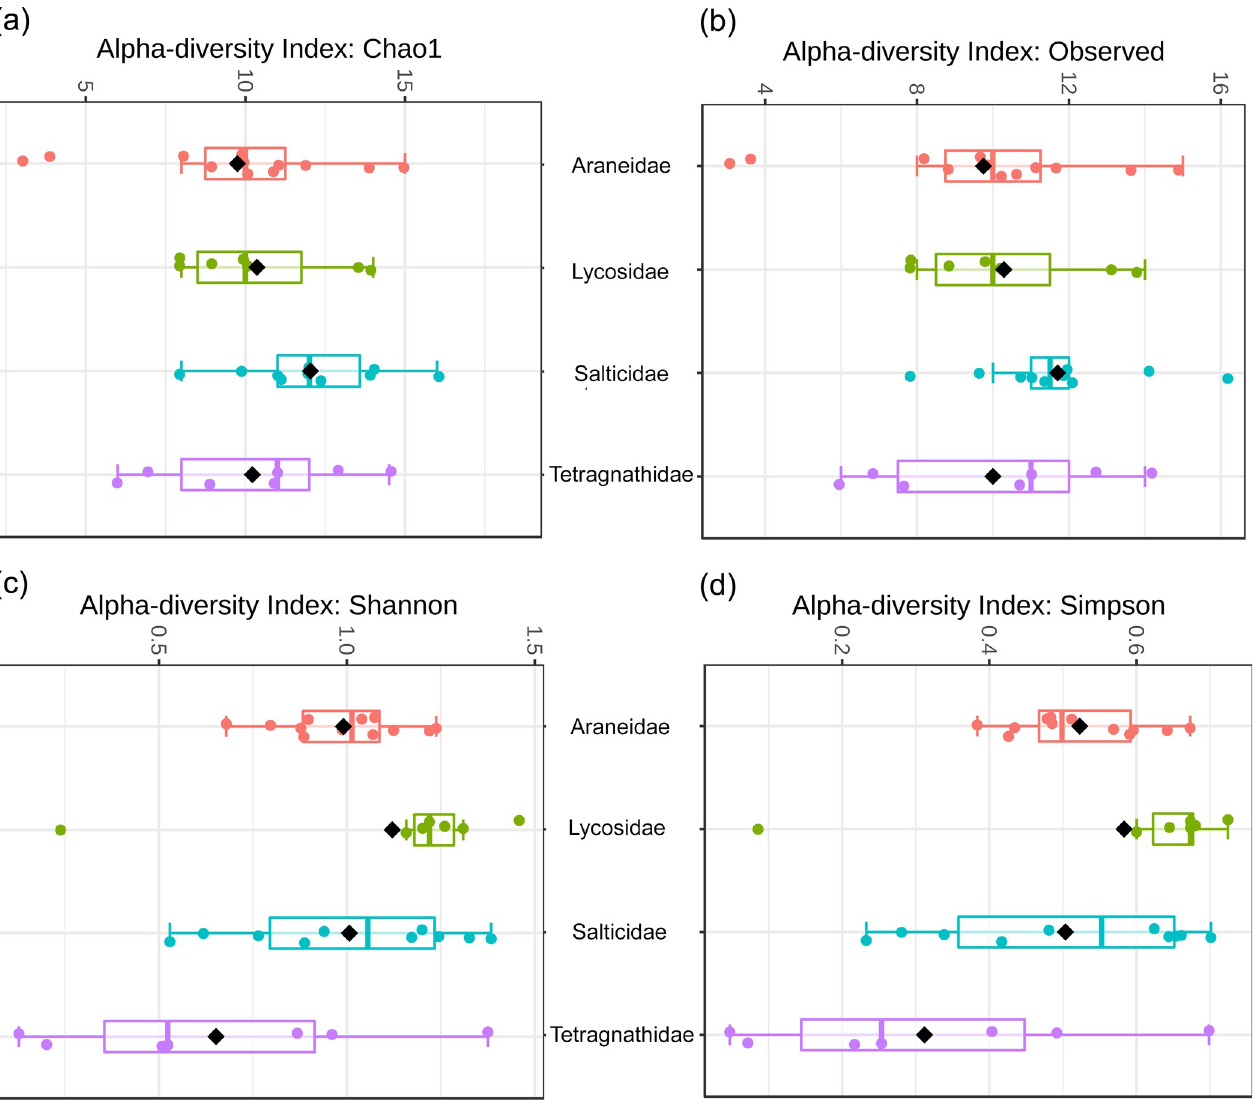
Fig 4. Alpha-diversity of four spider families based on (a) observed, (b) Chao1, (c) Shannon and (d) Simpson metrices.